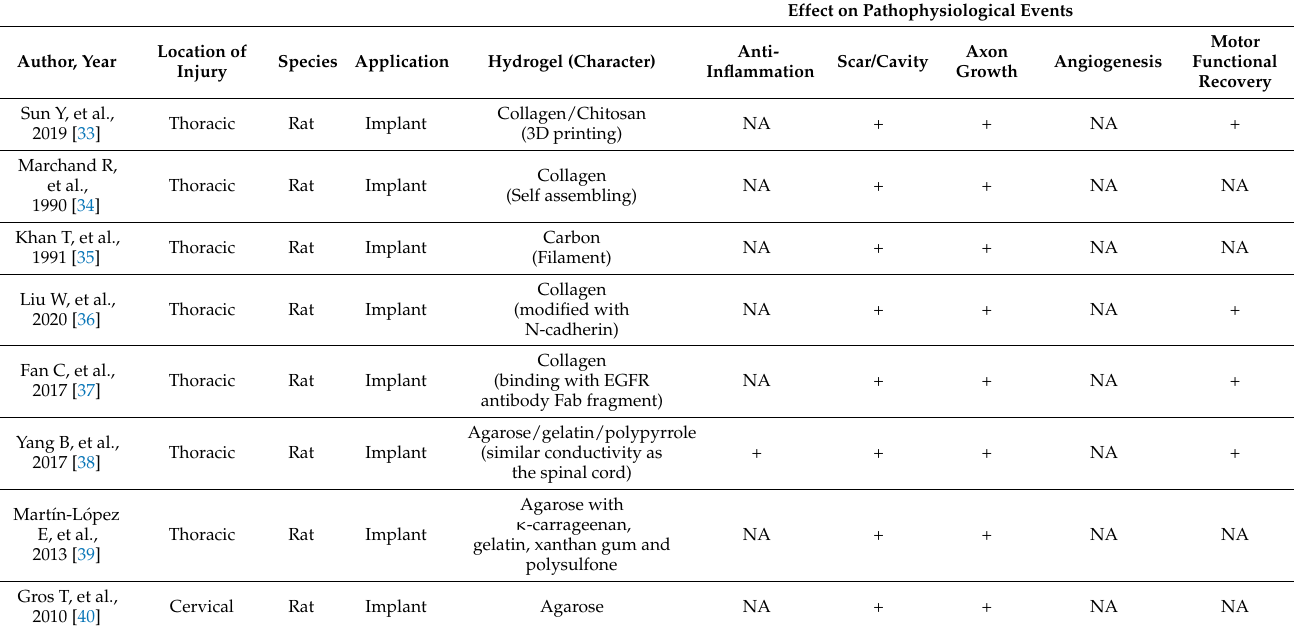
Table 1. Summary of the included studies and the effect of hydrogel application in